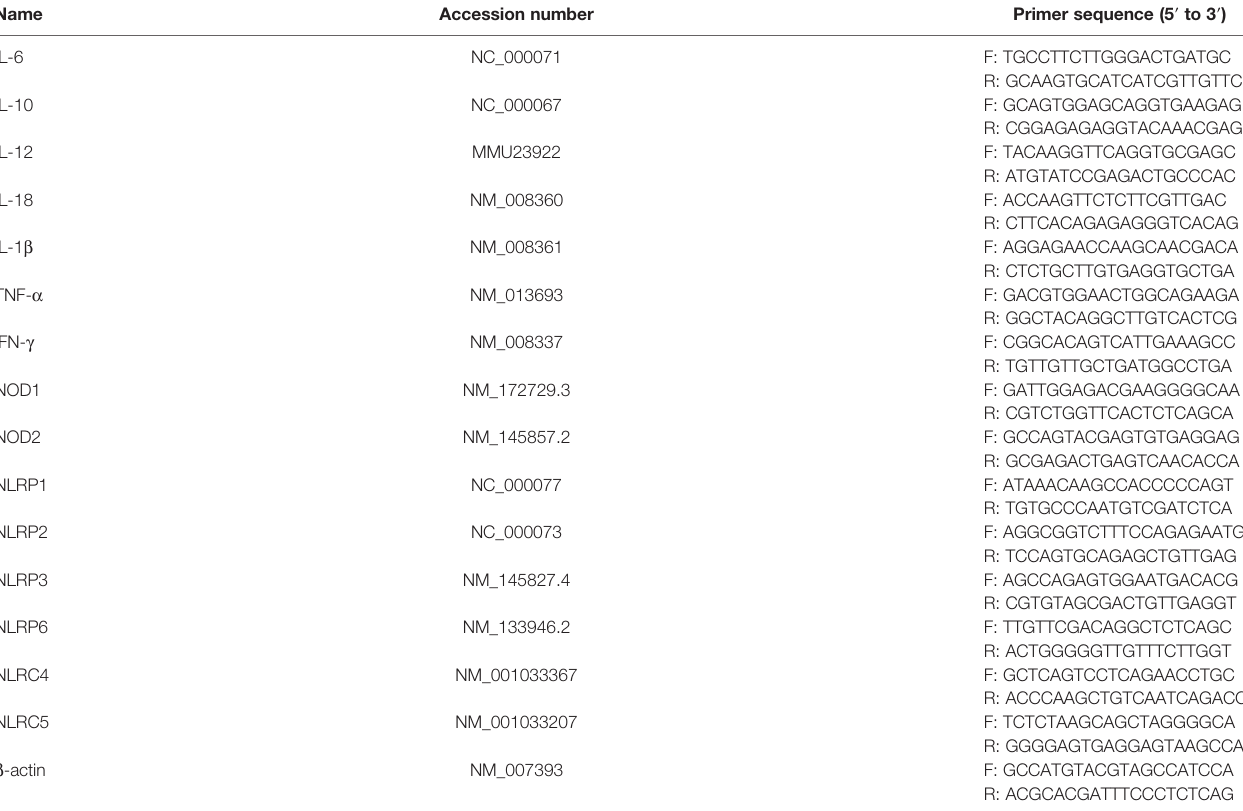
TABLE 1 | qPCR primer sequences of in fl ammatory cytokines and